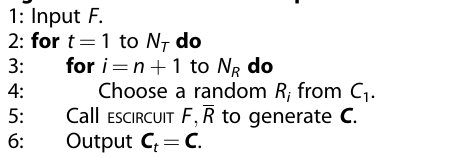
Algorithm 3 . Uniform importance Clifford sampling . 1: Input F , a conditional distribution g ð R 0 j R Þ and an initial slot- gate pattern R ð 0 Þ